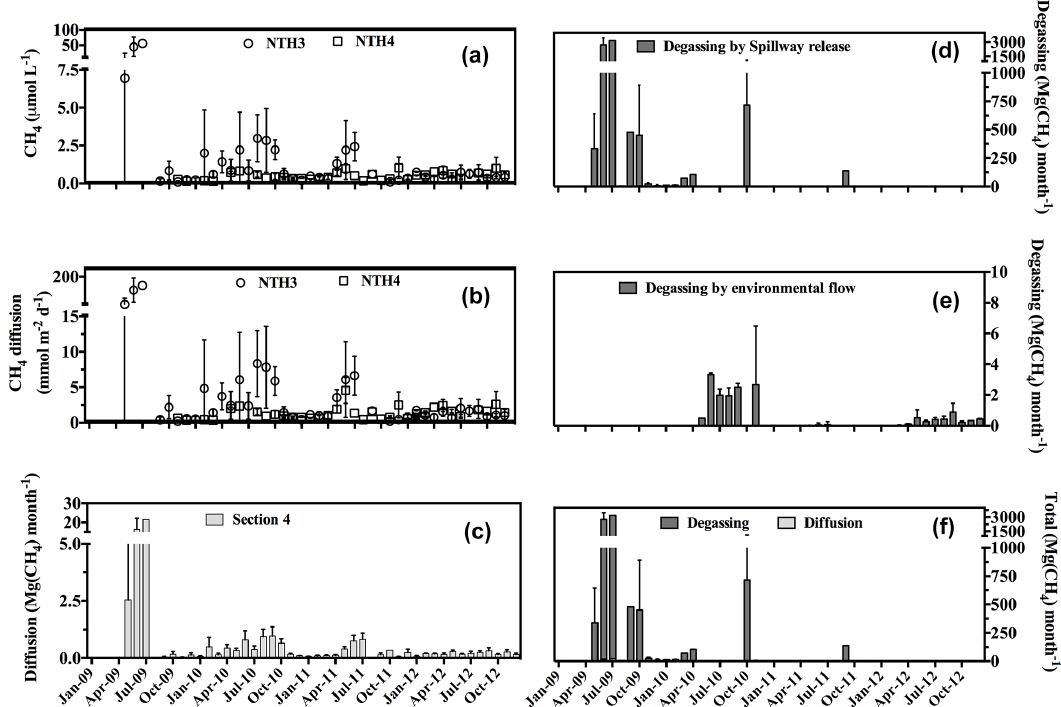
Figure 3. Methane concentrations and emissions downstream of the Nakai Dam at the Nam Theun 2 Reservoir between 2009 and 2012. (a) Time series of CH 4 concentrations at stations NTH3 and NTH4, (b) diffusive fluxes at stations NTH3 and NTH4, (c) emissions by diffusive fluxes in section 4 (between NTH3 and NTH4), (d) degassing due to spillway release below the Nakai Dam, (e) degassing below the Nakai Dam due to the continuous water discharge of 2m 3 s − 1 , and (f) total emissions by degassing and diffusion downstream of the Nakai